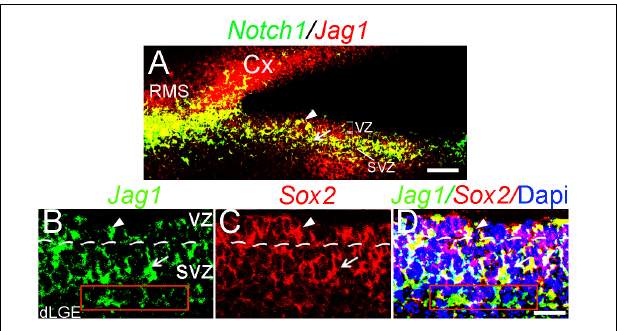
FIGURE 2 | Jag1 is expressed in VZ, SVZ, and rostral migratory stream. (A–D) In situ hybridization expression of Jag1 , Notch1 , and Sox2 mRNA probes on adjacent sagittal brain sections at E17.5. (A) Merged images of Notch1 and Jagged1 show coexpression in the RMS, VZ, and SVZ. Scale bar = 100 µ m. (B) Expression of Jag1 probe (green). (C) Expression of Sox2 probe (red). (D) Overlay (yellow) of Jag1 and Sox2 expression in the VZ and SVZ counter-stained with DAPI (blue). The VZ ( ∼ 1–3 cells from the neuroepithelial surface) and SVZ ( ∼ 4–8 cells from the neuroepithelial surface) were measured using DAPI. Scale bar = 30 µ m. Arrowheads indicate VZ; arrows indicate SVZ. Cx, cortex; RMS, rostral migratory stream; VZ, ventricular zone; SVZ, subventricular